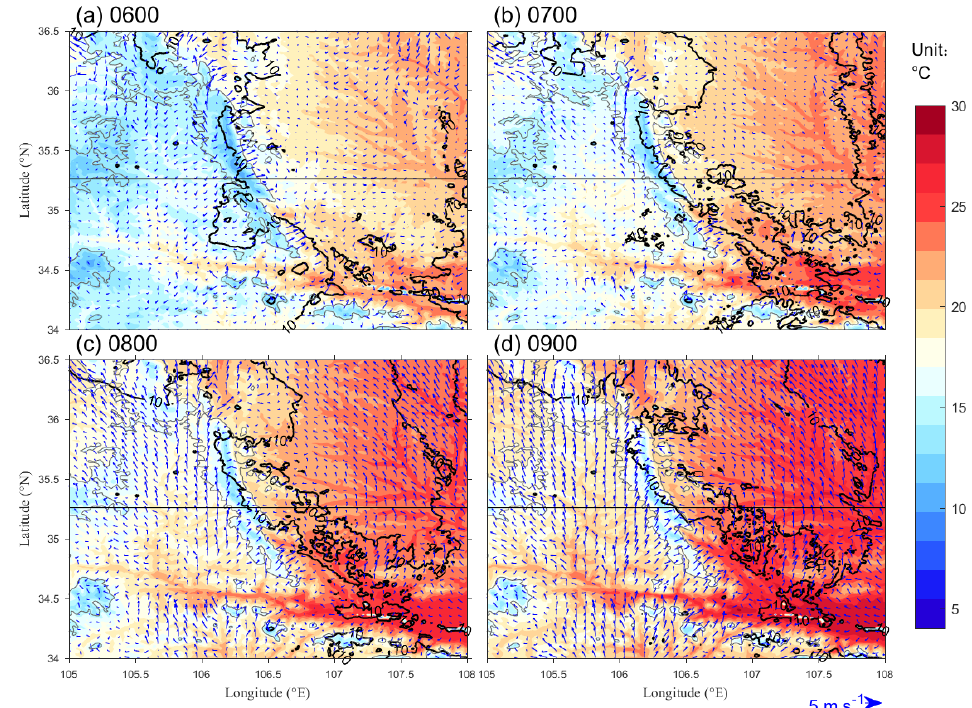
Figure 5. Simulated temperature (shaded, units: ◦ C) and specific humidity (black thick line, units: g kg − 1 ) at 2 m overlapped with 10 m wind field (blue vector, units: m s − 1 ), ( a ) 0600, ( b ) 0700, ( c ) 0800, and ( d ) 0900 LST. The gray thin lines are the 2000 m terrain contours, the black solid line is the location of the cross-section shown in Figure 6.